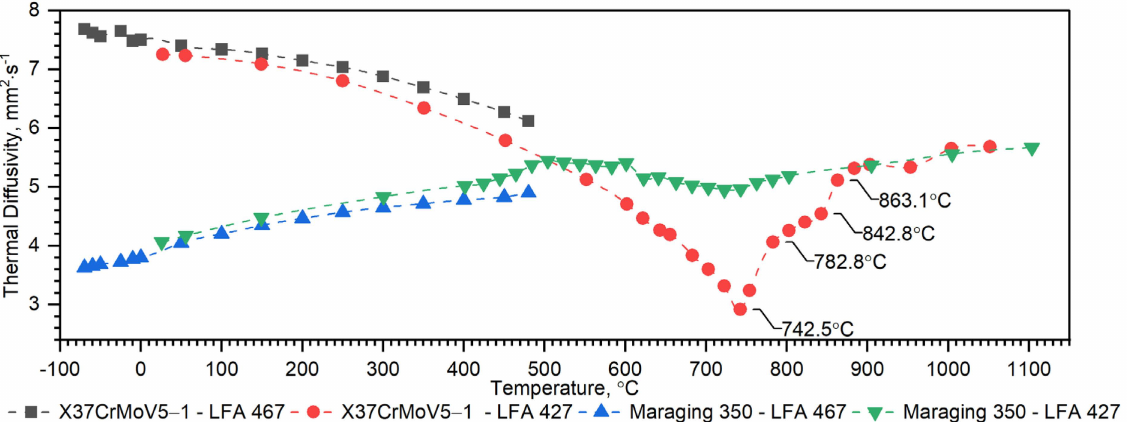
Figure 7. Thermal diffusivity as a function of temperature for the X37CrMoV5 − 1 hot-work tool steel and Maraging 350 steel obtained from the first heating runs on LFA 467 and LFA